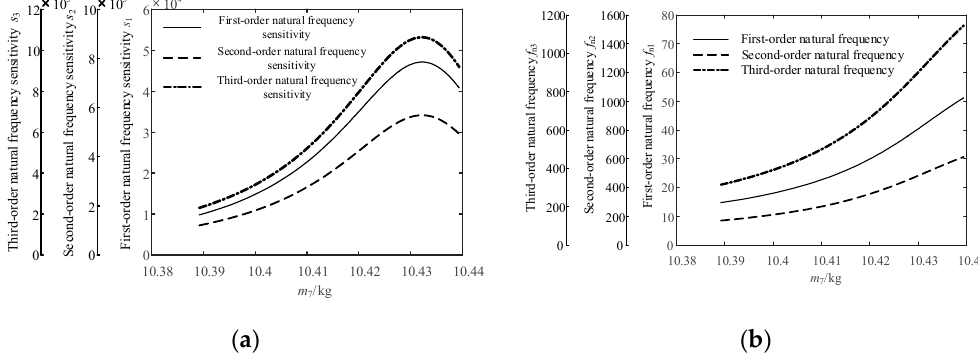
Figure 7. The variation law of the first three natural frequencies and their sensitivities of the jet system under a different pressure of the fluid with the mass of fluid unit 1. ( a ) Variation law of natural frequency sensitivity. ( b ) Variation law of natural frequency.